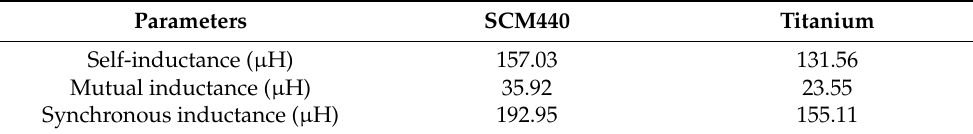
Figure 2. Line-to-line back-EMF at no-load according to shaft materials: ( a ) SCM440 shaft and ( b ) titanium shaft. Table 2. Inductance characteristics according to the shaft